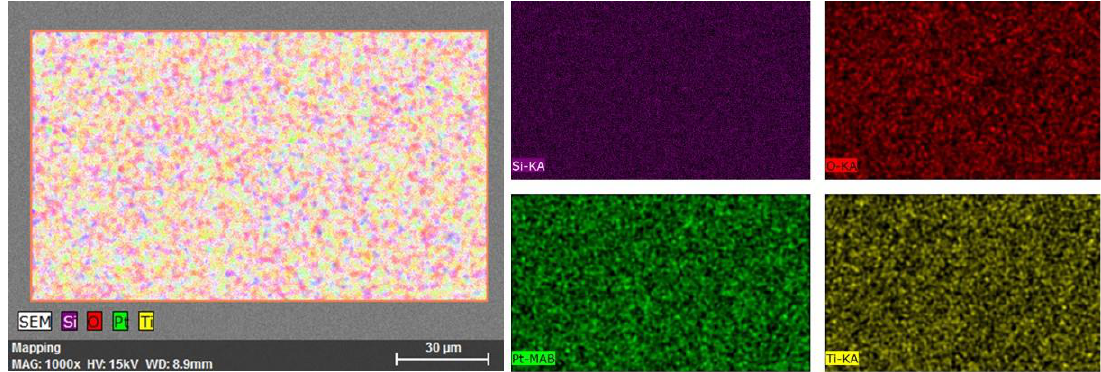
Figure 3. Graphical elemental mapping for PtTi thin film deposited on a glass substrate at 1000× magnification and 15 kV acceleration voltage.